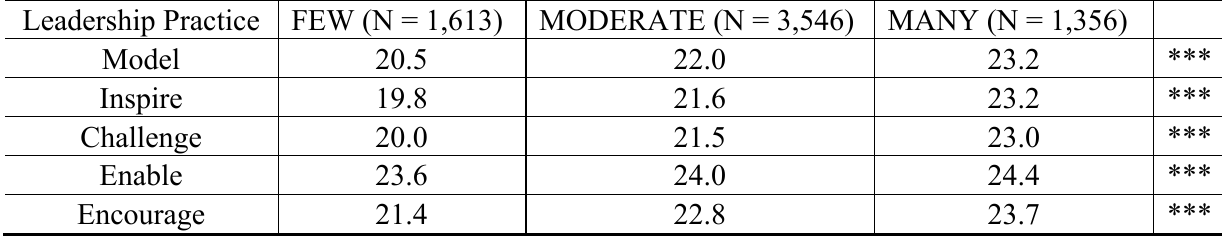
Table 9. Comparisons between Respondents by Opportunities to Both Be a Leader and Develop Leadership Skills (Self).